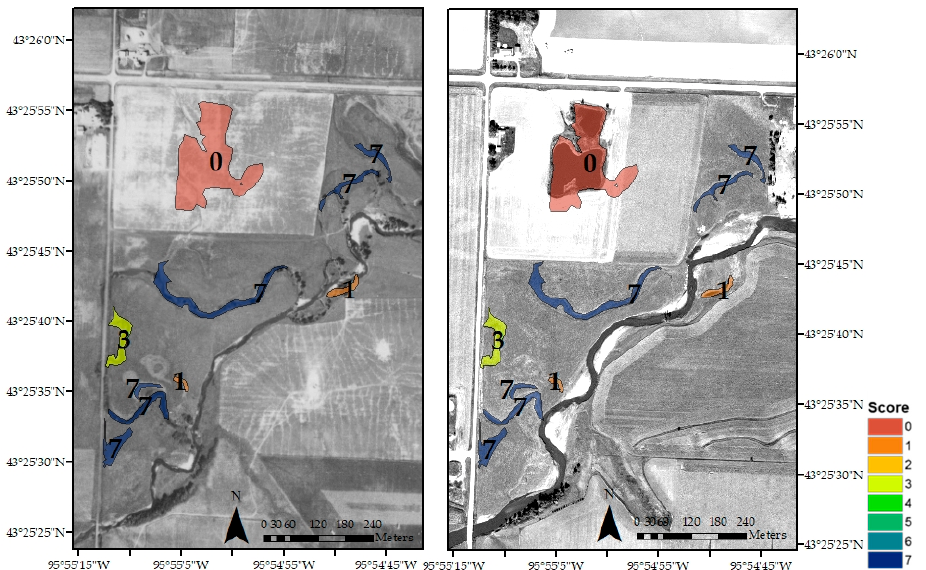
Figure 4. Ranked candidate sites based on the conditional probabilities of each feature defined by the model for all-watersheds in historical 1930 aerial imagery ( Left ); recent 2015 aerial imagery ( Right ). Depressions that were ranked as oxbows but had the lowest conditional probability were given lower scores than depressions that had greater conditional probabilities. A score of 0 represents depressions less likely to be a target feature and a score of 7 is most likely to be a target feature.